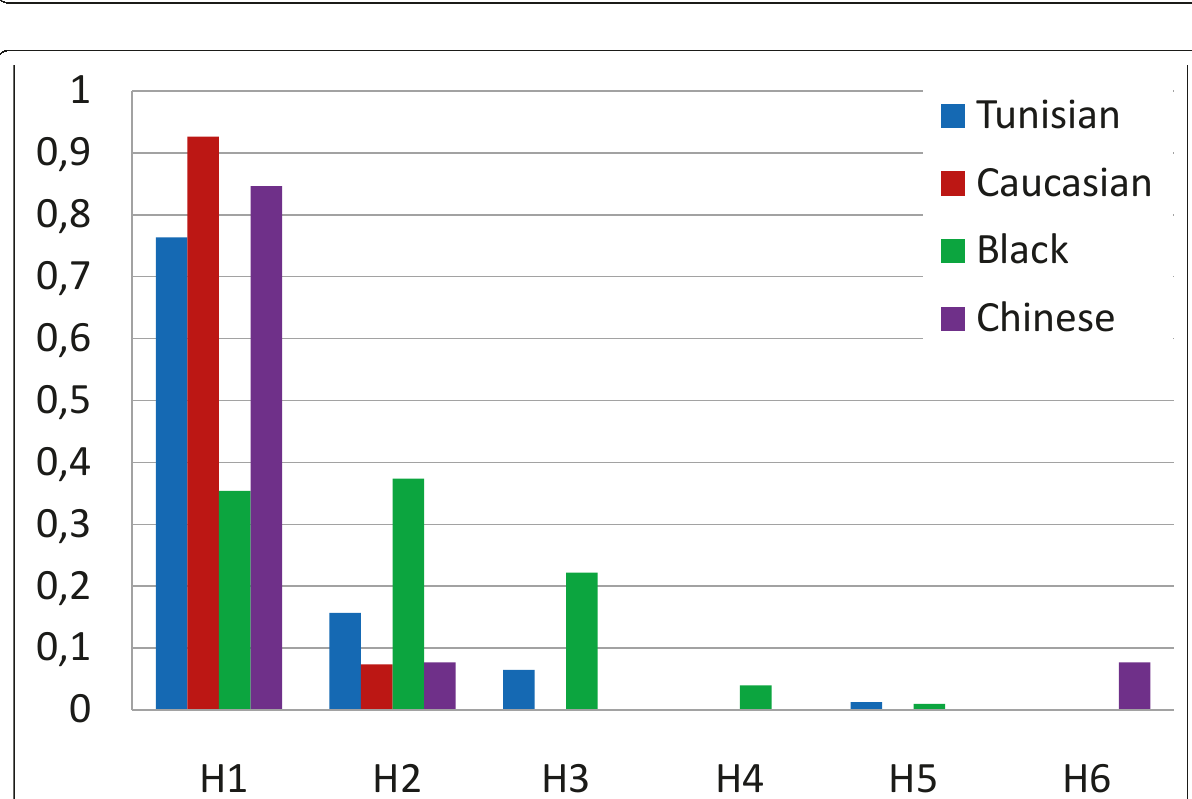
Figure 1 Haplotype frequencies of factor VIII gene identified in Tunisian hemophiliac A .